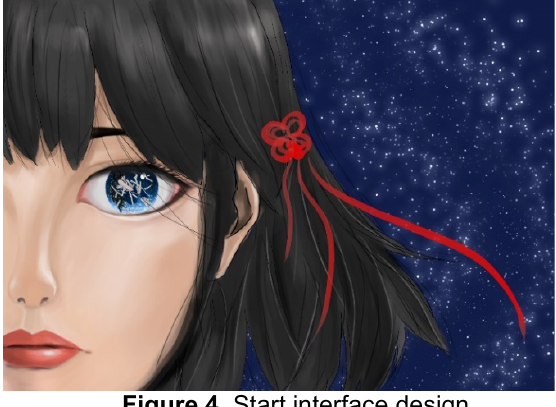
Figure 4. Start interface design